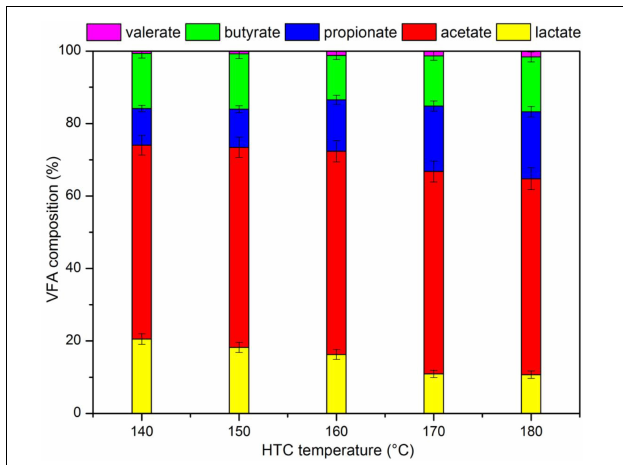
FIGURE 2 | Volatile fatty acids (VFA) composition of liquid products (LP) after hydrothermal pretreatment (HTP).